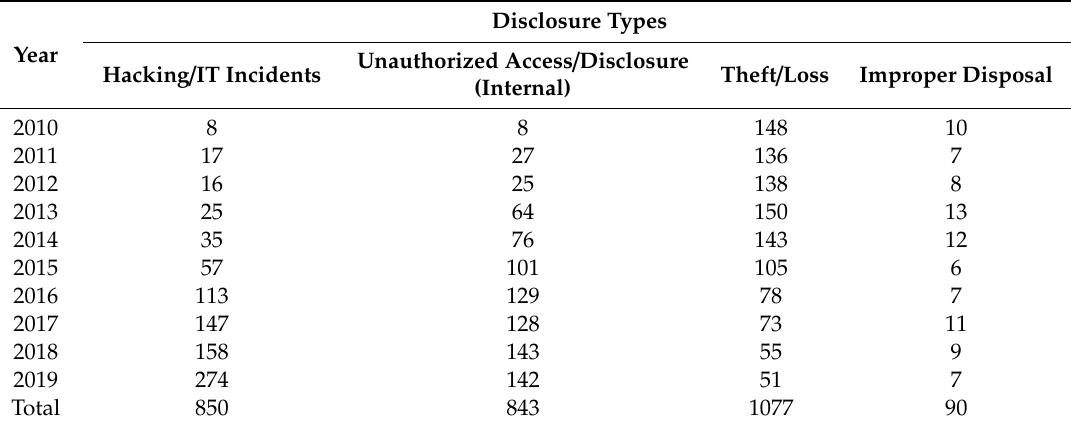
Table 5. Type of Healthcare Data Breaches.